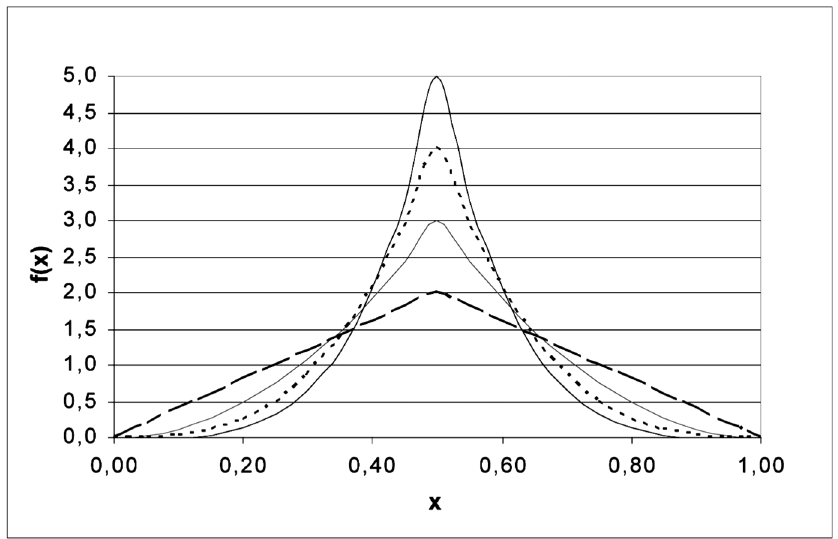
Figure 7 – Symmetrical STSP distribution ( θ =0.5, κ